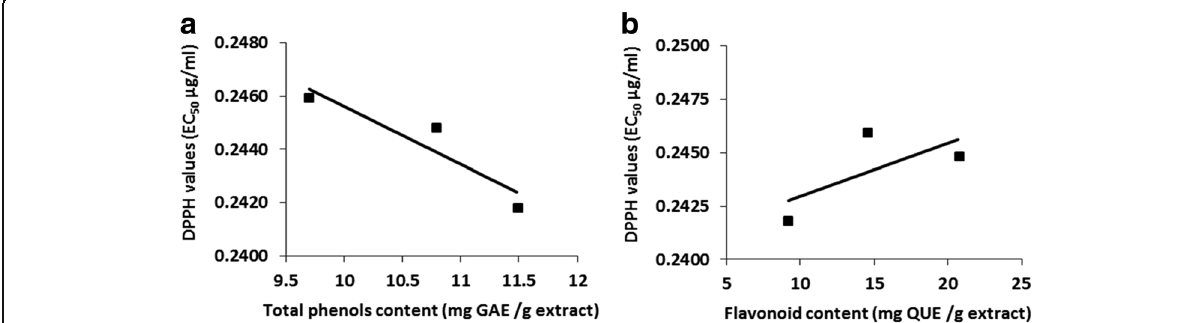
Fig. 3 Linear correlations between the amount of total phenols and DPPH· radical scavenging activity ( a ) and between the flavonoid content and DPPH· radical scavenging activity ( b )